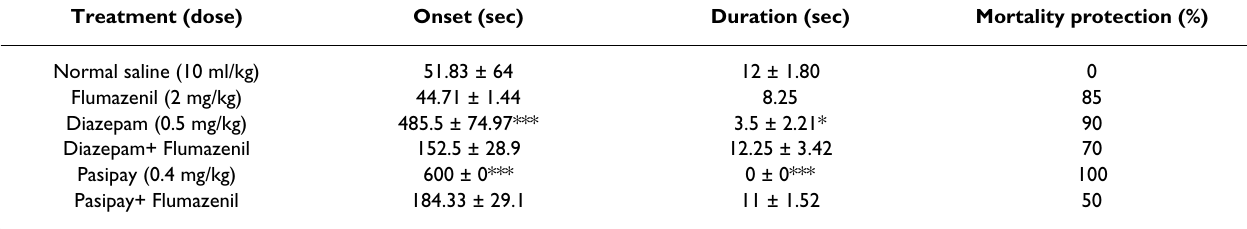
Table 2: Effect of flumazenil on the anticonvulsant activity of Pasipay and diazepam in PTZ-induced convulsion in mice Treatment